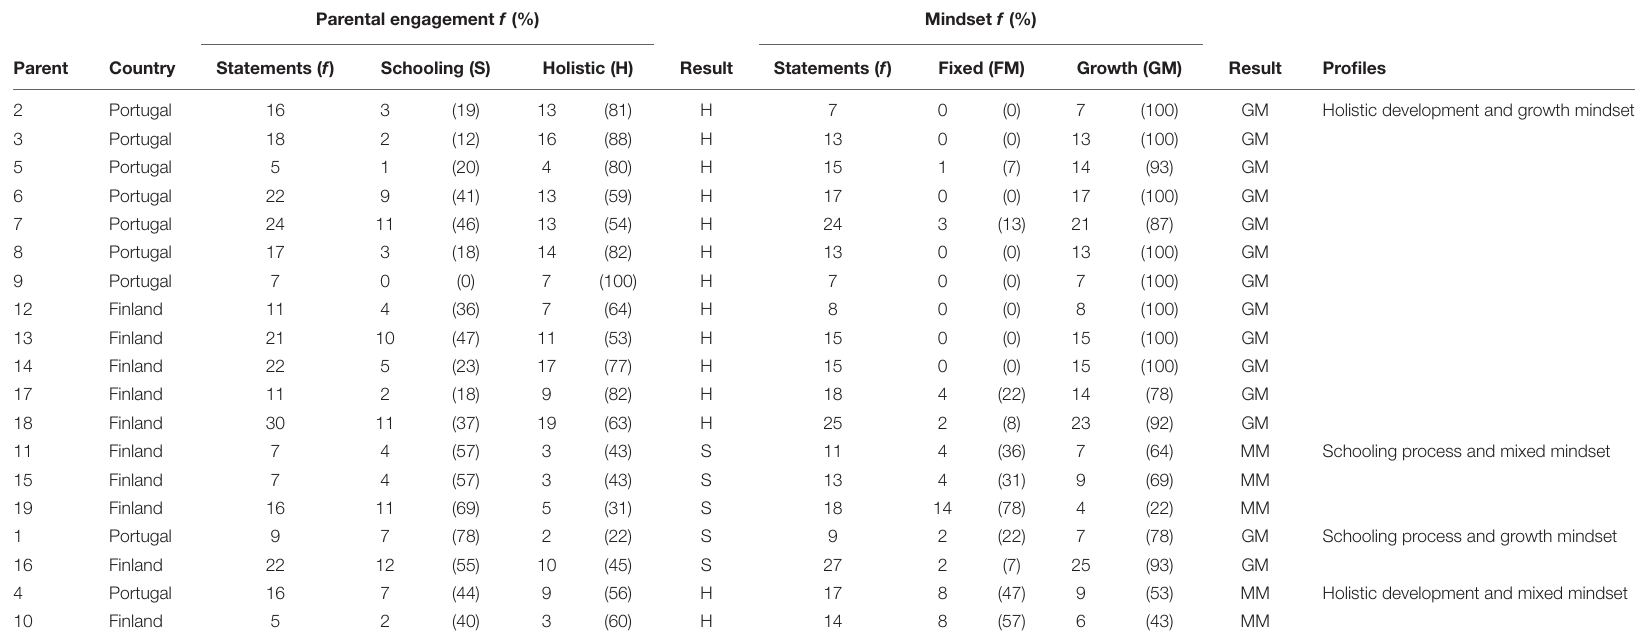
TABLE 4 | Parental engagement–mindset